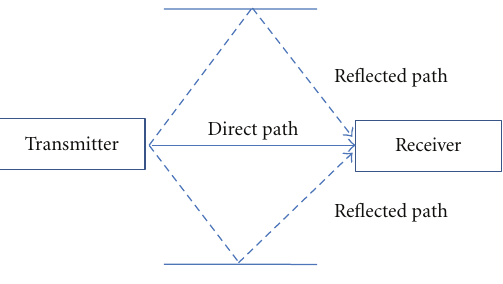
Figure 1: Rician fading